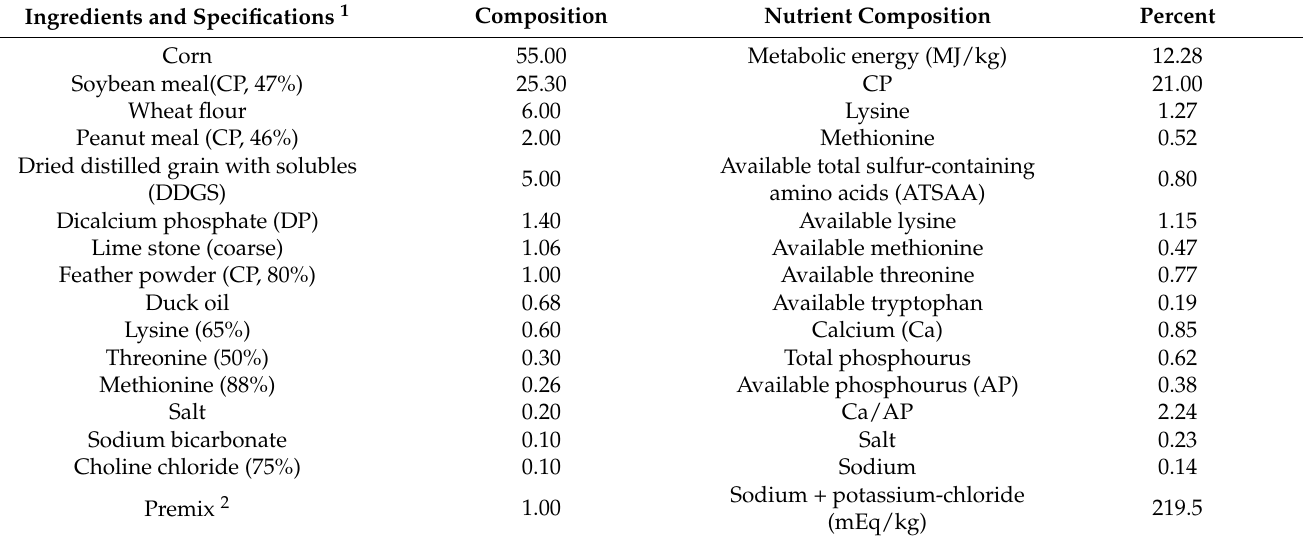
Table 1. Ingredients and nutrient levels of the commercial feed and the control feed for all trials.